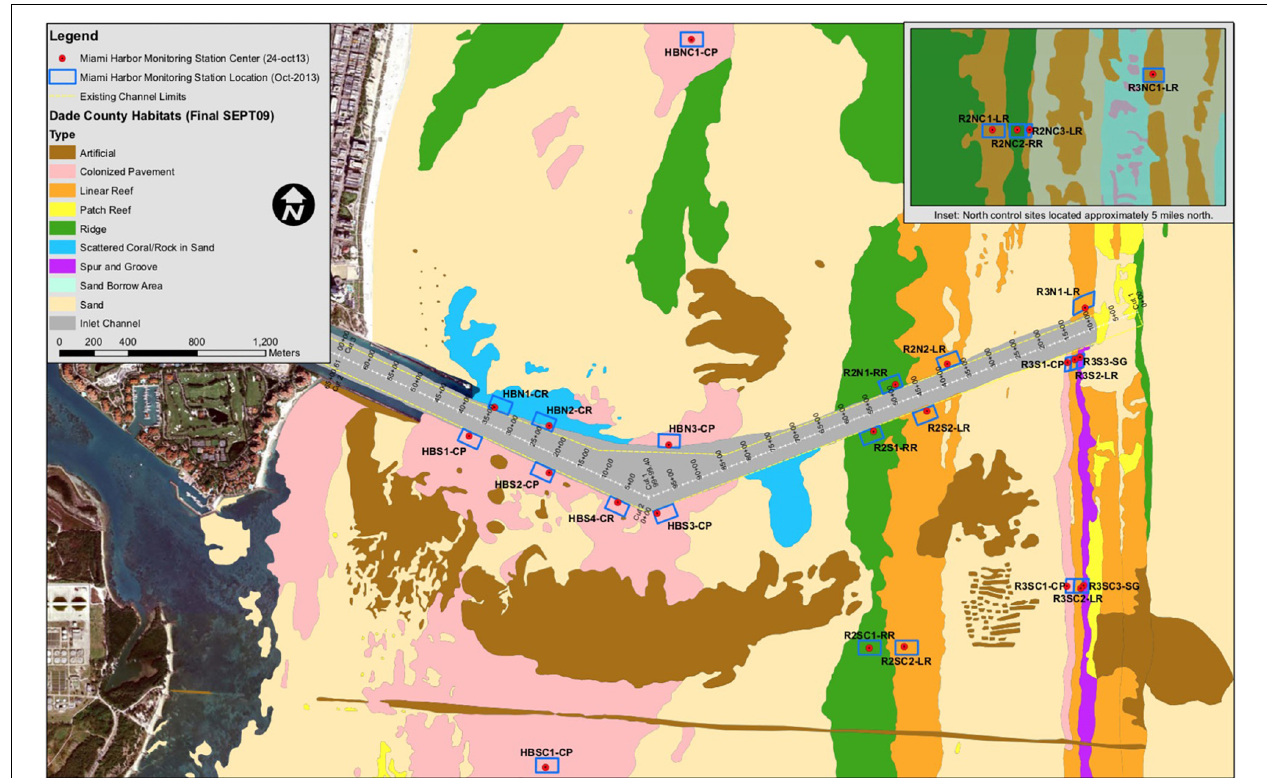
FIGURE 1 | Location map of 26 monitoring sites (blue boxes) associated with the Port Miami Deepening Project. Site abbreviations are noted next to each box. Brown horizontal line across the lower portion of the figure is the location of the outfall pipe trench for the Central Miami-Dade Wastewater Treatment